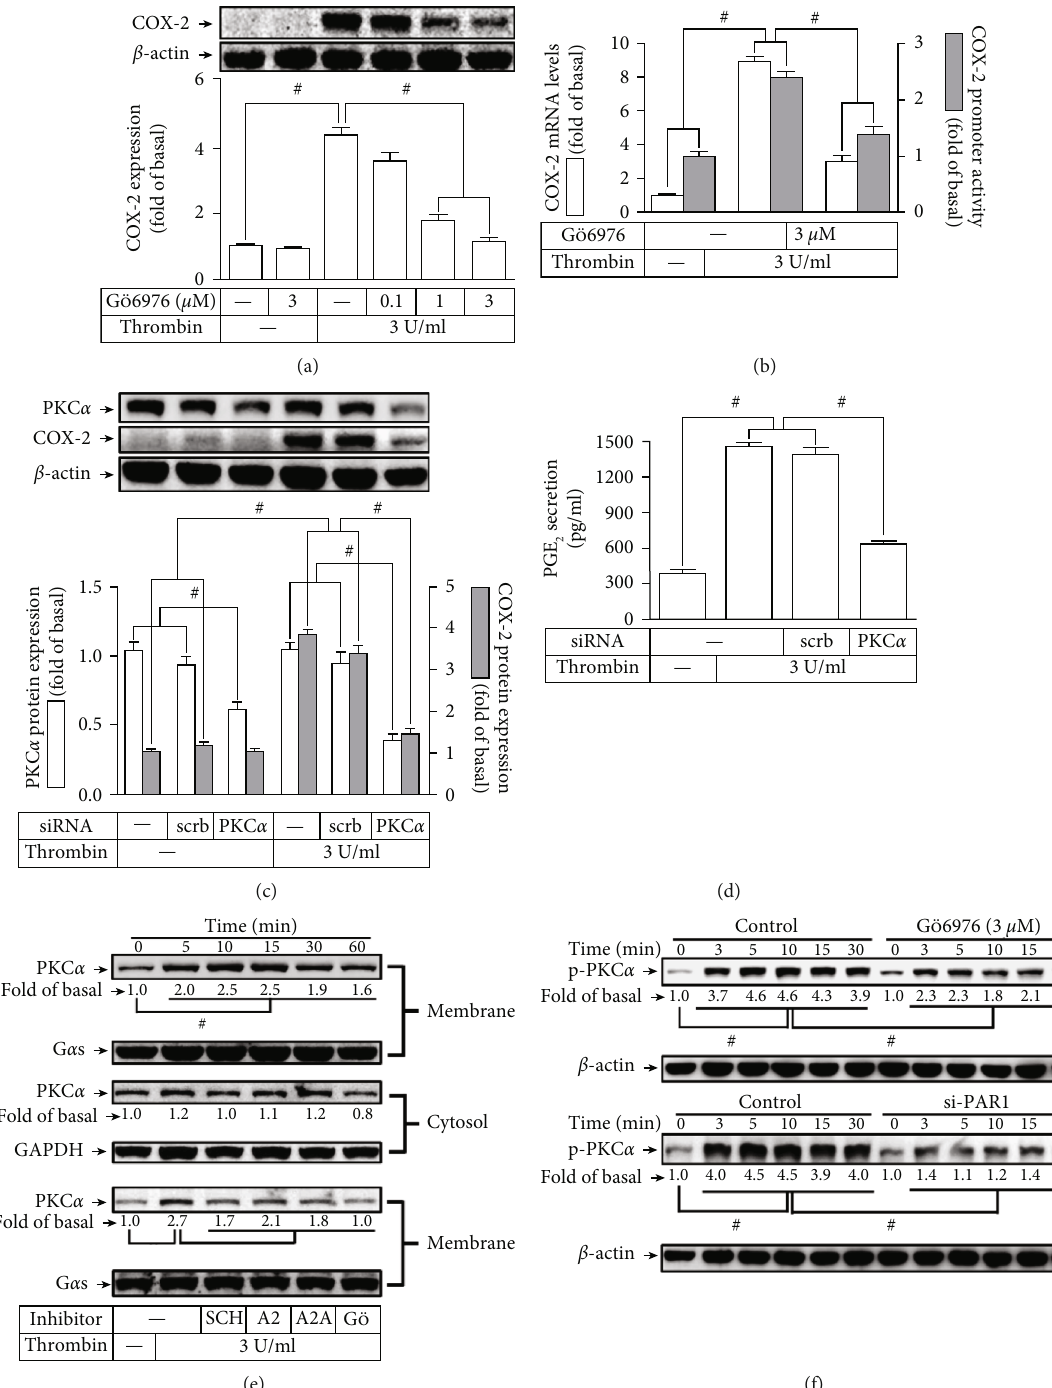
Figure 3: Thrombin induces COX-2 expression via PKC α . (a) Cells were pretreated with Gö6976 for 1h and then incubated with thrombin for 6 h. The levels of COX-2 protein were determined. (b) Cells were pretreated with Gö6976 (3 μ M) for 1h and then incubated with thrombin for 4 h. The mRNA levels and promoter activity of COX-2 were determined. (c) Cells were transfected with either scrambled or PKC α siRNA and then incubated with thrombin for 6 h. The levels of PKC α and COX-2 protein were determined. (d) The media saved from (c) were used to determine the levels of PGE generation. (e) Cells were treated with 3U/ml thrombin for the indicated time 2 intervals. The membrane and cytosolic fractions were prepared and subjected to Western blot using an anti-PKC α antibody. GAPDH and G α s were used as a marker protein for cytosolic and membrane fractions, respectively. (f) Cells were pretreated with SCH79797 (10 μ M), GPA2 (1 μ M), or GPA2A (1 μ M) for 1 h and then treated with thrombin for 10min. The membrane fractions were prepared and subjected to Western blot using an anti-PKC α antibody. Data are expressed as mean ± S : E : M : of three independent experiments. # P < 0 : 05 , as compared with the control or pretreatment with inhibitor indicated in the fi